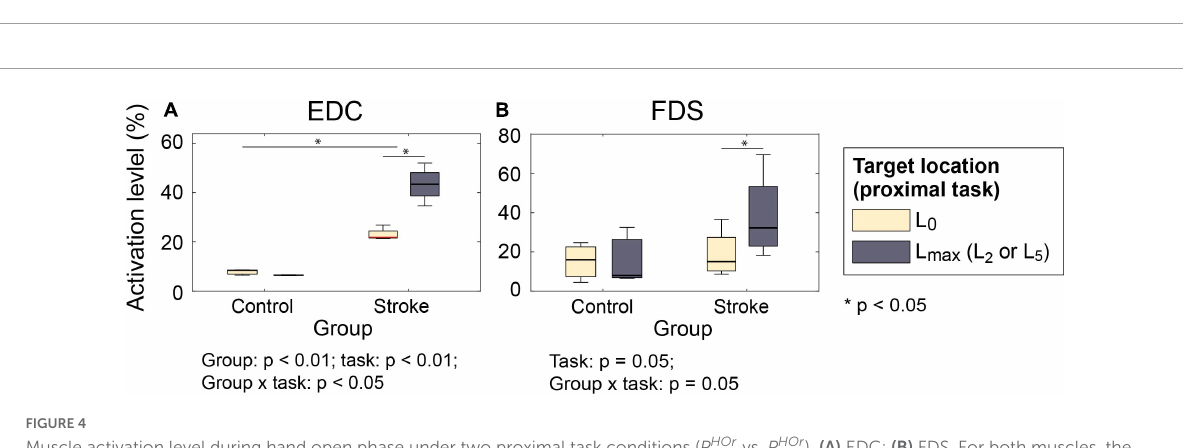
FIGURE3 Distal kinematics of two subject groups under two proximal task conditions ( P HOr T 1 vs. P HOr T 2 ). (A) Finger MCP (MCP 23F ); (B) finger PIP (PIP 23F ); (C) thumb IP (IP 1F ) joint flexion angles. For each box, the central mark indicates median, and the bottom and top edges of the box indicates 25th and 75th percentiles, respectively (MCP, metacarpophalangeal; PIP, proximal interphalangeal). The whiskers extend to the most extreme data points excluding outliers (which were indicated by “+” symbols).